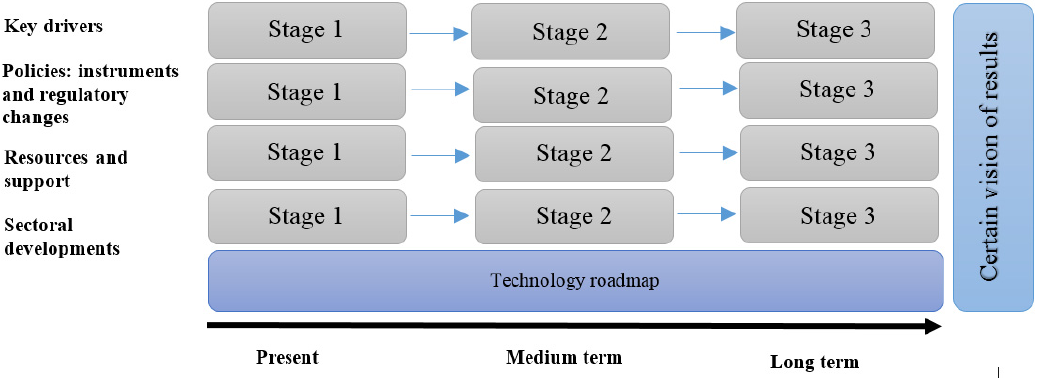
Figure 2. Framework for innovation policy roadmap creation.